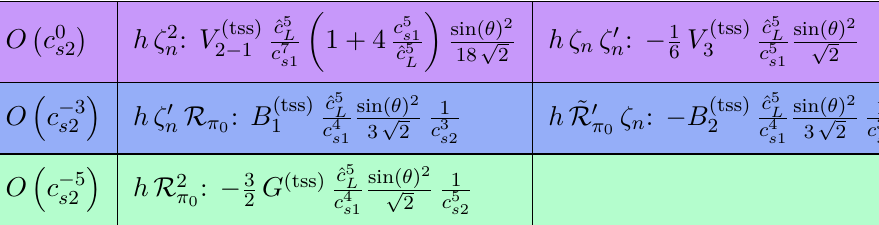
(cid:16) = V (tss) 2 − 1 1